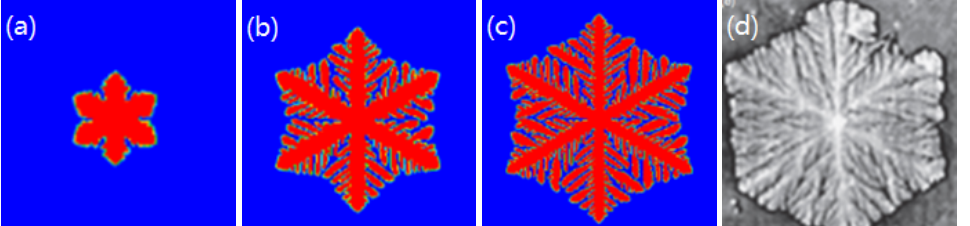
Figure 4. When K 0 = 1.5, and the morphology of dendrites is obtained by numerical simulation. (( a – c ) are the numerical simulation results with time iteration steps of 1000, 3000 and 5000, respectively. ( d ) is the experimental result).